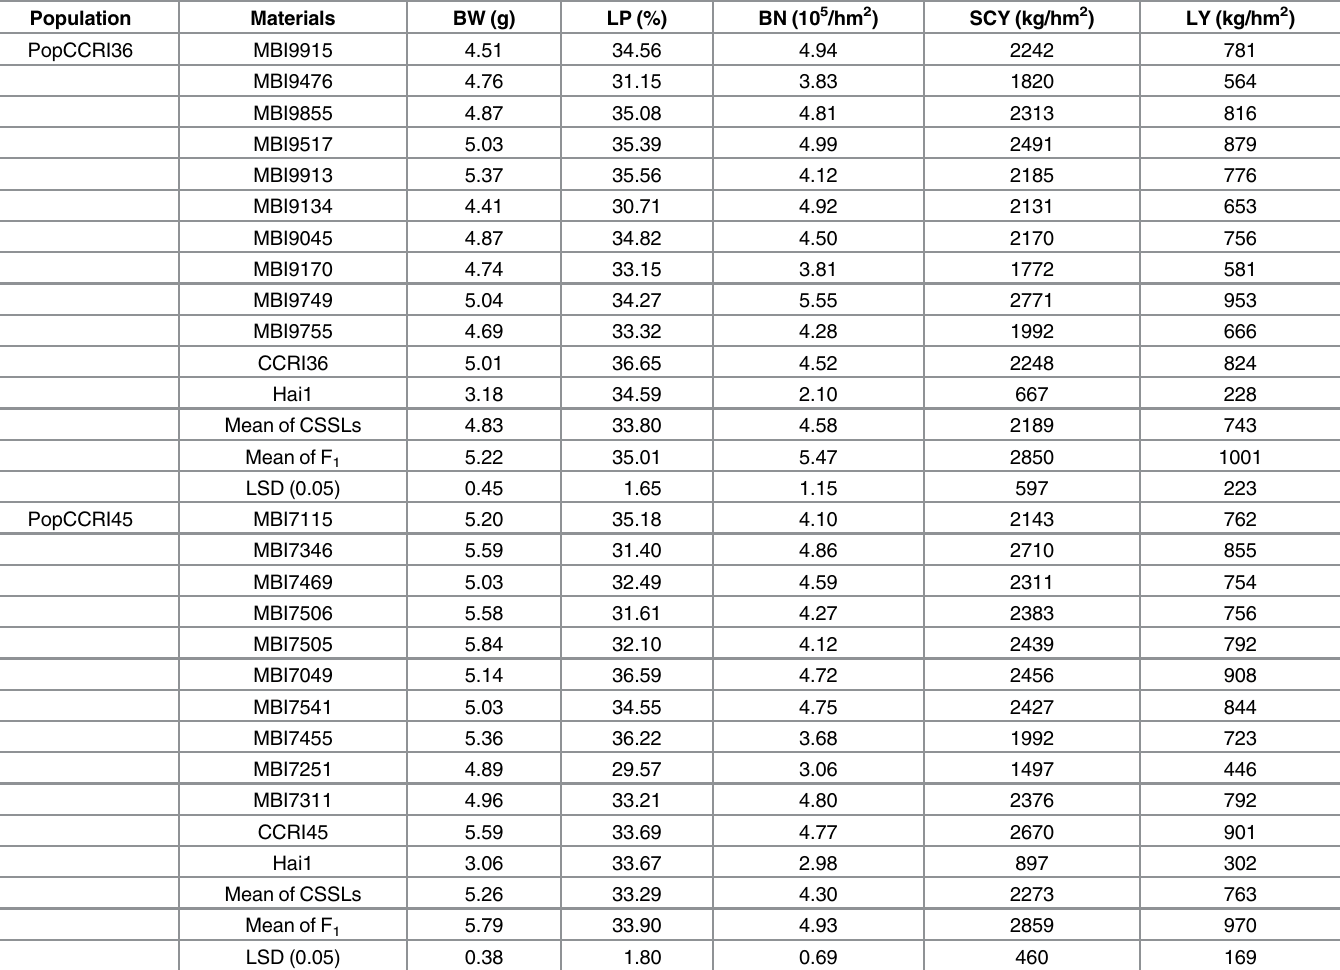
Table 1. Phenotypic means of yield and yield components for parents and F 1